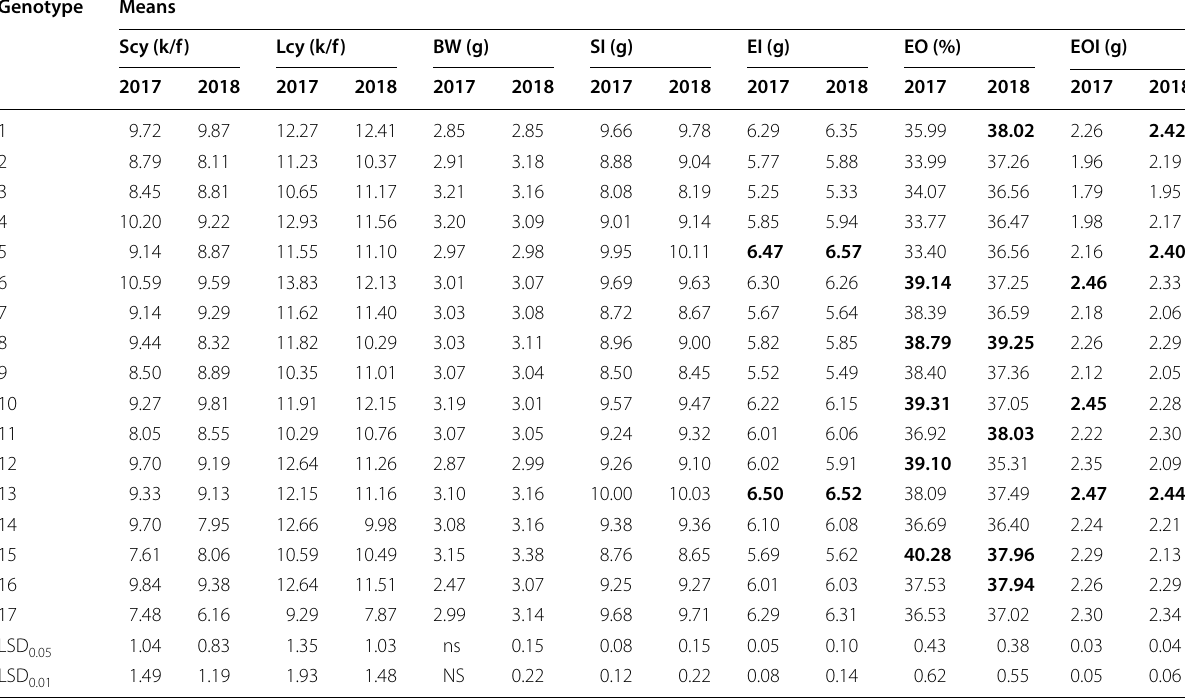
Scy seed cotton yield (k/f), Lcy lint cotton yield (k/f), BW boll weight (g), SI seed index (g), EI embryo index (g), EO embryo oil percentage (%), EOI Embryo oil index (g)